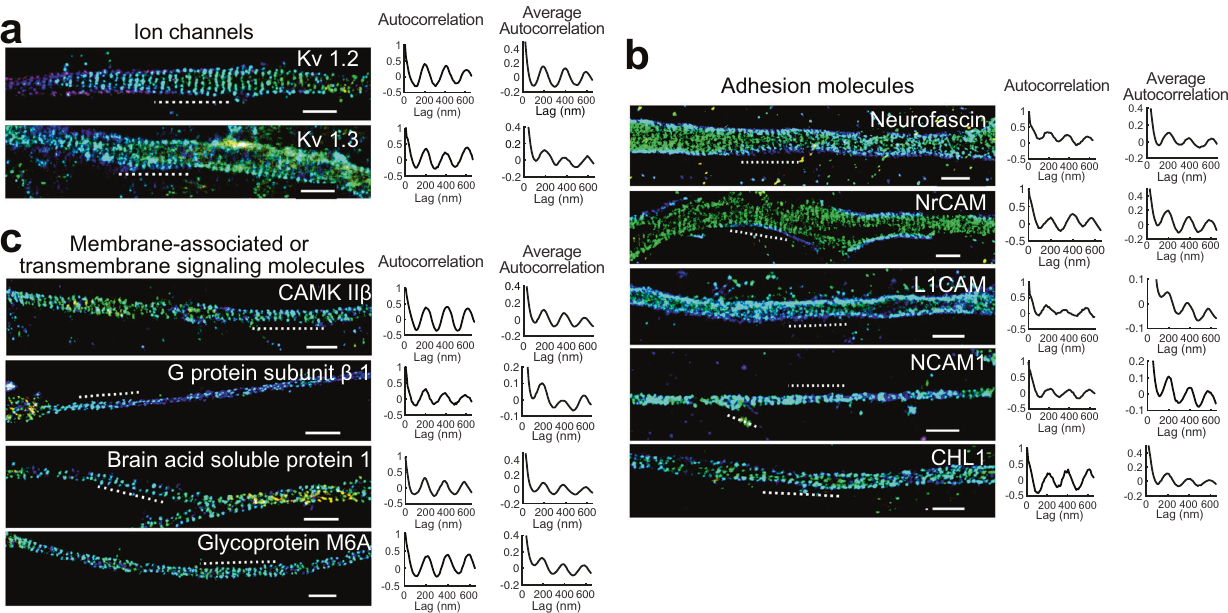
Fig. 4 STORM imaging of transmembrane proteins or membrane-bound signaling proteins associated with the MPS. a Left: 3D STORM images of two potassium channel subunits, K v 1.2 and K v 1.3, in axons. Middle: 1D autocorrelation of the imaged proteins for the axon region indicated by the dashed line in the left panels. Right: Average 1D autocorrelation of the imaged proteins over 20 – 90 randomly chosen axon regions. b Same as ( a ) but for fi ve cell adhesion molecules, including neurofascin, NrCAM, L1CAM, NCAM1 and CHL1. c Same as ( a ) but for three membrane-associated (non-transmembrane) signaling molecules, including calcium/calmodulin-dependent protein kinase type II β (CAMK II β ), heterotrimeric G protein β -subunit 1, and brain acid soluble protein 1, as well as a transmembrane signaling molecule, glycoprotein M6A. STORM images in a – c are representative examples from three independent experiments with similar results. Scale bars: 1 μ m. Source data are provided as a Source Data fi